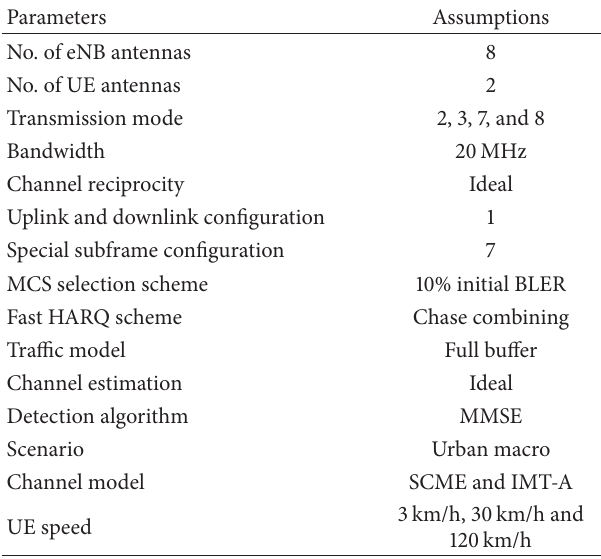
Table 1: Simulation